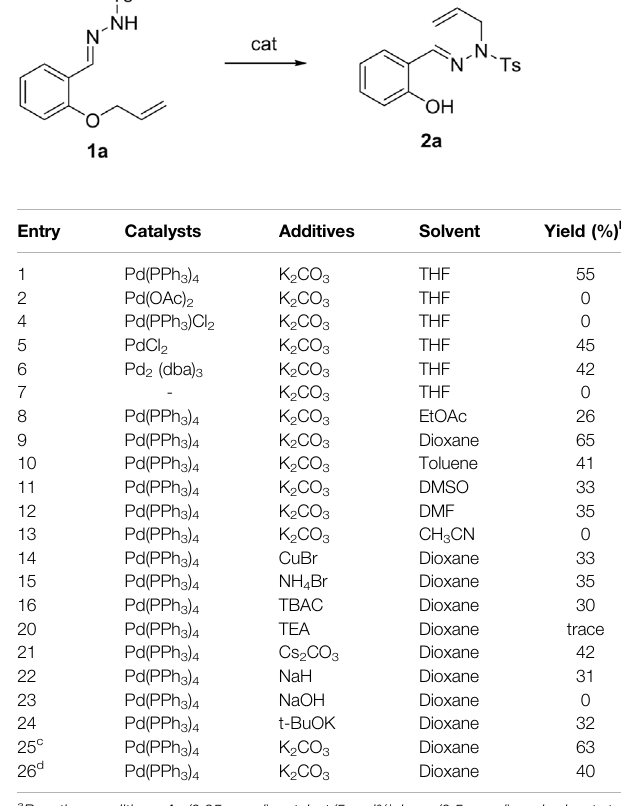
TABLE 1 | Screening of reaction conditions a .